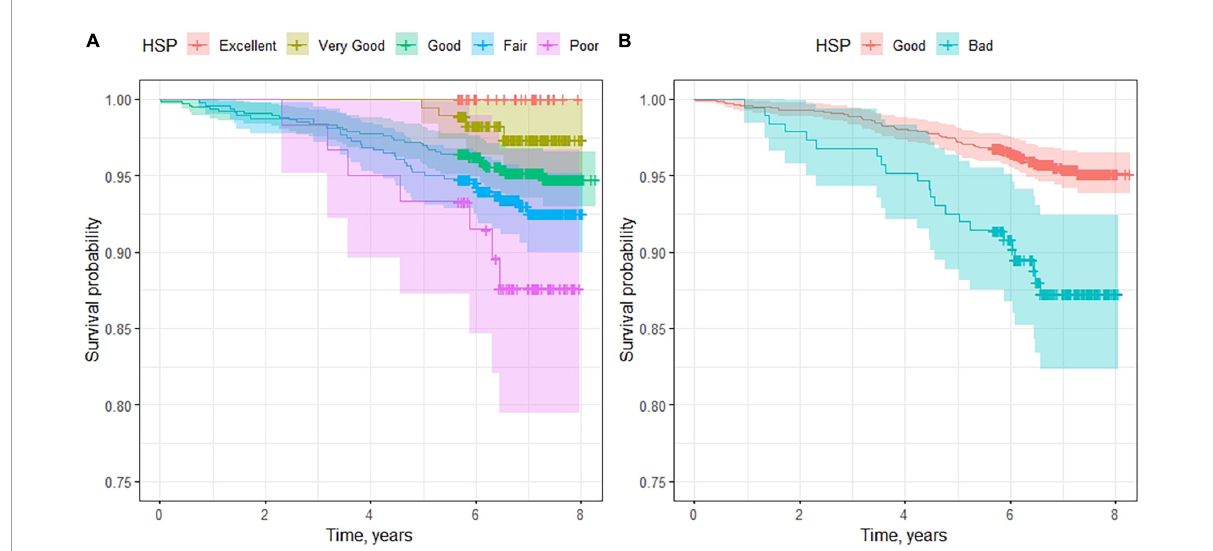
FIGURE1 Survival curves for patients according to their self-rated health. In (A) , we consider the five groups defined in the SF-36 questionnaire. (B) Shows the survival curves for good and poor health self-perception.